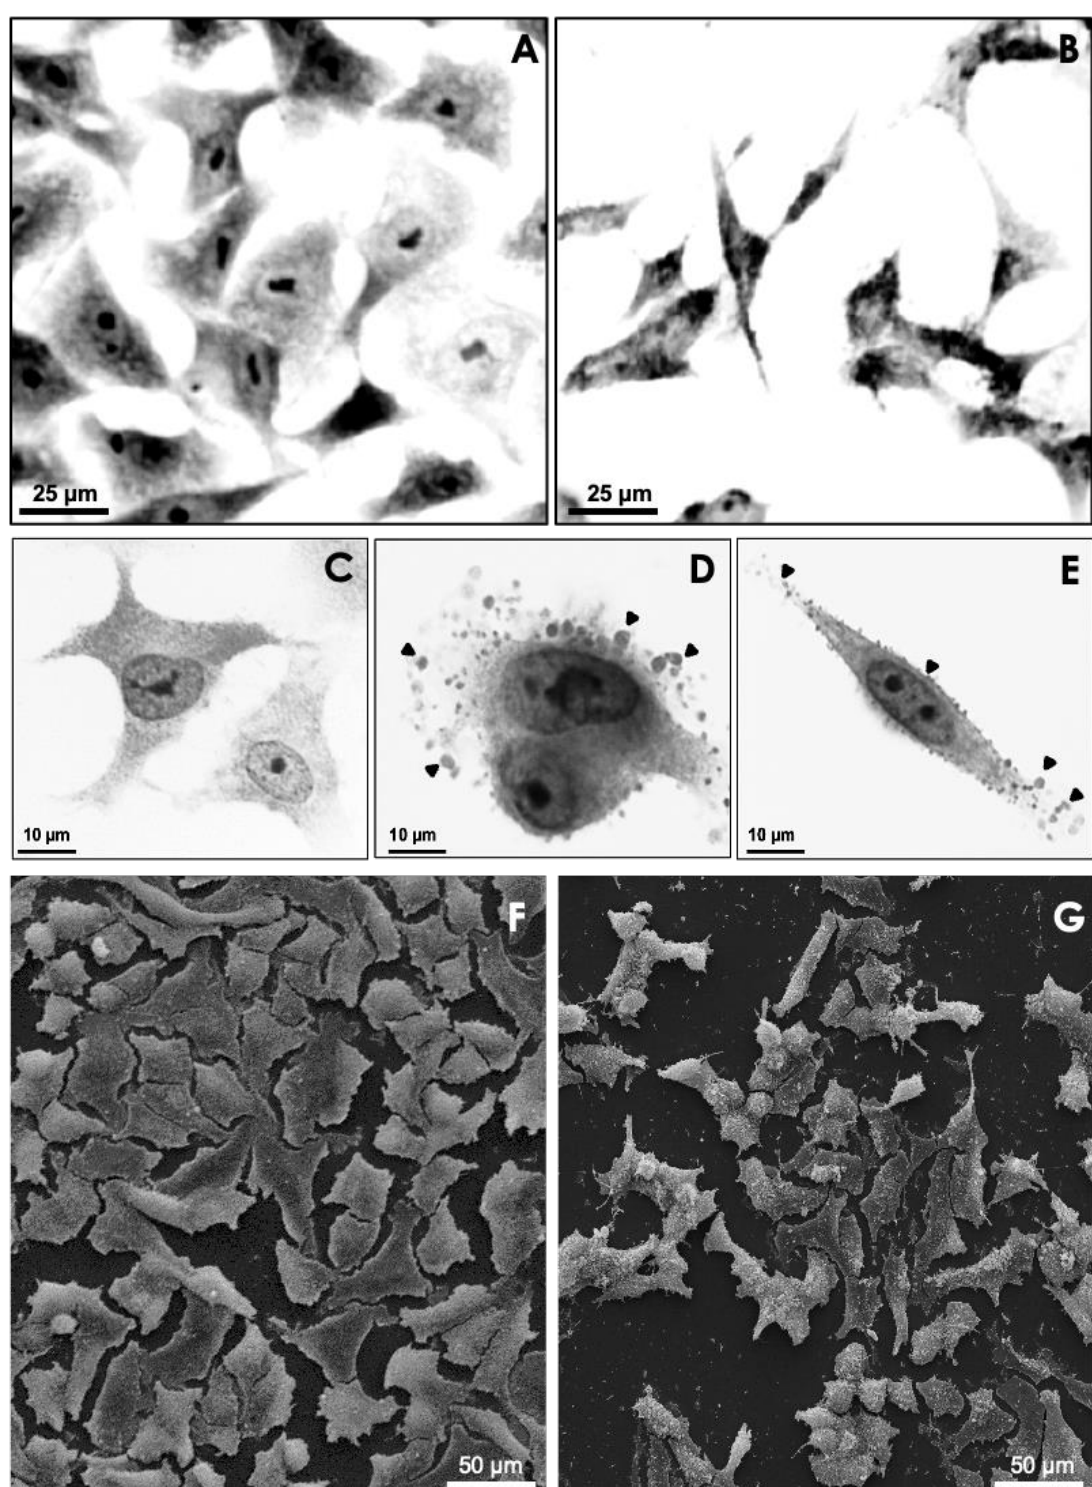
Figure 4. Light microscopy ( A – E ) and scanning electron microscopy (SEM) ( F , G ) images representing the monolayer of A549 epithelial cells before ( A , C , F ) and after ( B , D , E , G ) incubation with secreted molecules from S. apiospermum mycelial cells. Note the morphological changes in A549 cells, such as the release of the monolayer ( B , G ) and the presence of bubbles (arrowheads in D , E ) on the epithelial cell surface. (Adapted from Silva et al. 2012 [35].)